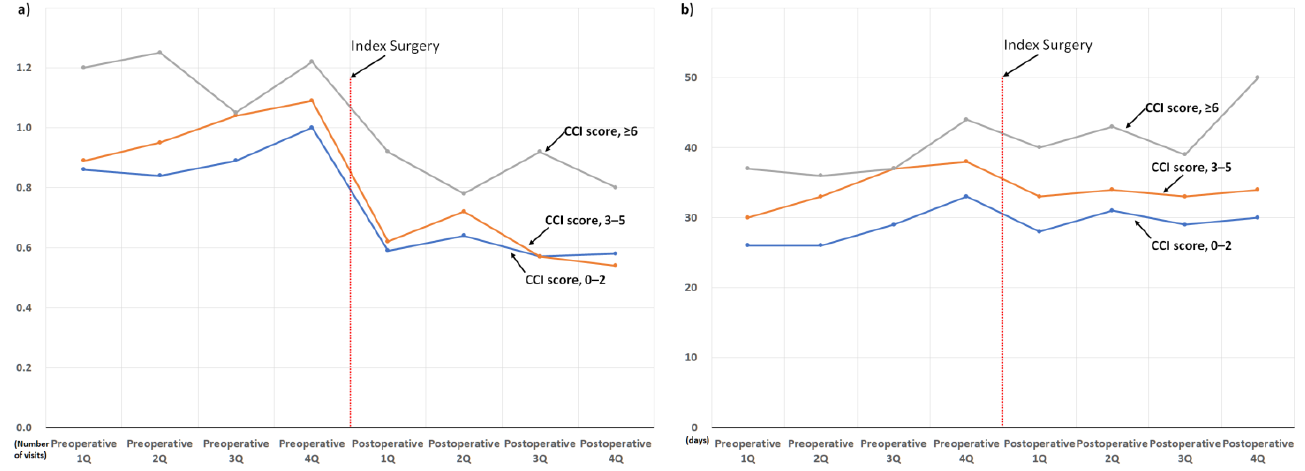
Figure 7. Perioperative changes in the use of sleep medication and hospital visits owing to sleep disorder according to the Charlson comorbidity index (CCI) score: ( a ) changes in the number of hospital visits, and ( b ) changes in the prescribed duration of sleep medication.